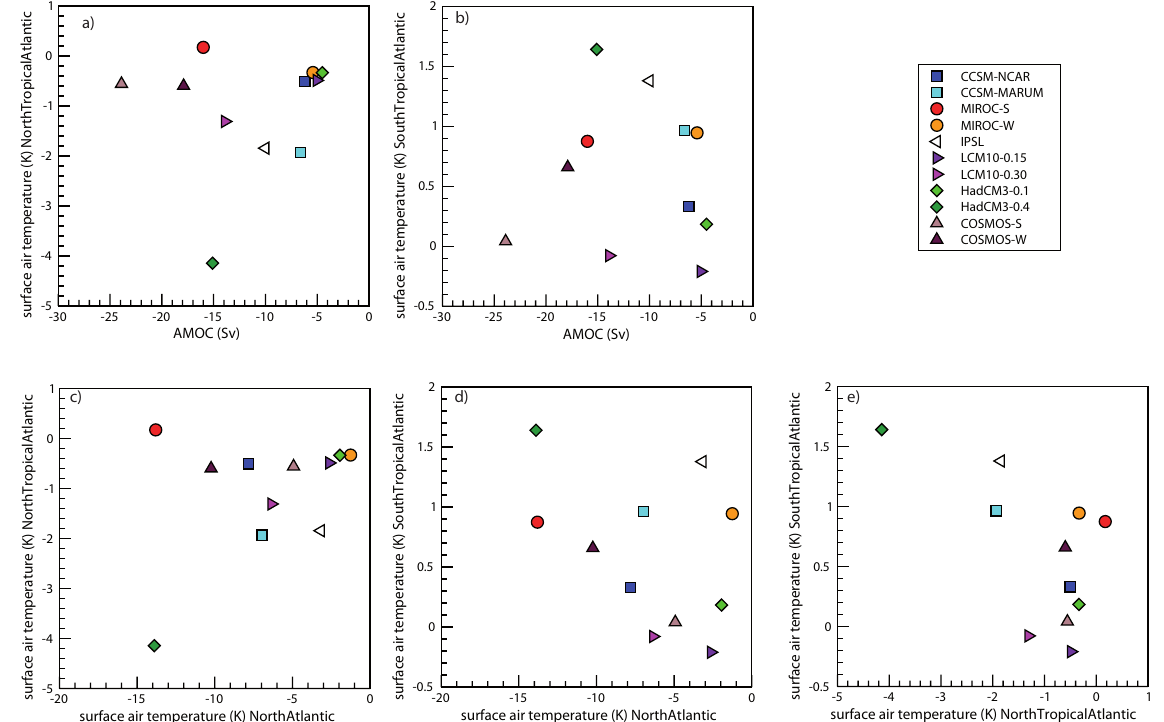
0 surface air temperature (K) NorthAtlantic Fig. 7. Relationships involving tropical Atlantic temperature changes related to fresh water hosing. The “NorthTropicalAtlantic” region is defined as the region with latitudes between 5 and 30 ◦ N and longitudes between 50 and 15 ◦ W. The “SouthTropicalAtlantic” region is defined as the region with latitudes included between 20 ◦ S and 5 ◦ N and longitudes between 30 ◦ W and 10 ◦ E. Top: relationships between temperature changes over these regions and AMOC relative changes. Bottom: (left and middle) relationships between temperature changes over these regions and the NorthAtlantic (region defined in Fig. 6) temperature changes; (right) relationship between the temperature changes over the NorthTropicalAtlantic and SouthTropicalAtlantic